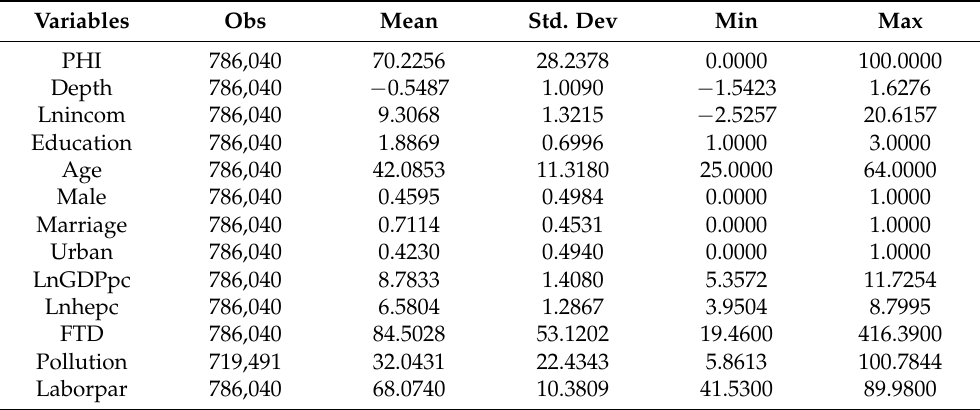
Table 3. Descriptive